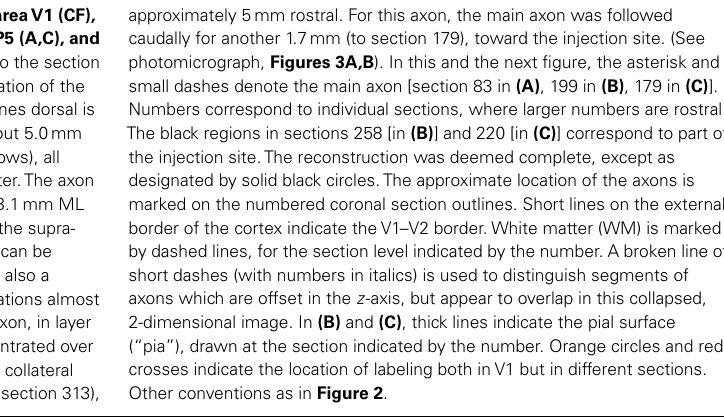
approximately 5mm rostral. For this axon, the main axon was followed caudally for another 1.7mm (to section 179), toward the injection site. (See photomicrograph, Figures 3A,B ). In this and the next figure, the asterisk and small dashes denote the main axon [section 83 in (A) , 199 in (B) , 179 in (C) ]. Numbers correspond to individual sections, where larger numbers are rostral. The black regions in sections 258 [in (B) ] and 220 [in (C) ] correspond to part of the injection site.The reconstruction was deemed complete, except as designated by solid black circles.The approximate location of the axons is marked on the numbered coronal section outlines. Short lines on the external border of the cortex indicate theV1–V2 border.White matter (WM) is marked by dashed lines, for the section level indicated by the number. A broken line of short dashes (with numbers in italics) is used to distinguish segments of axons which are offset in the z -axis, but appear to overlap in this collapsed, 2-dimensional image. In (B) and (C) , thick lines indicate the pial surface (“pia”), drawn at the section indicated by the number. Orange circles and red crosses indicate the location of labeling both inV1 but in different sections. Other conventions as in Figure 2